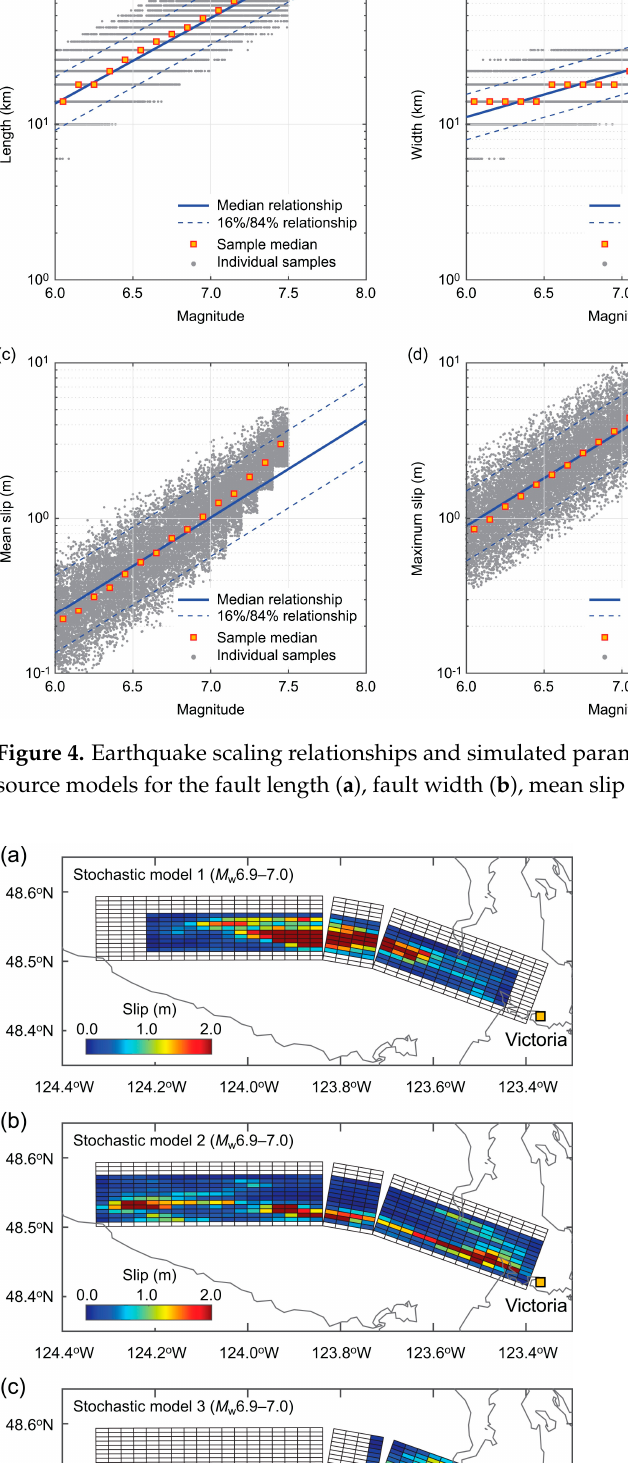
Figure 6. Average earthquake slip distributions of the 1000 stochastic source models: ( a ) M w 6.6–6.7 scenario, ( b ) M w 6.9–7.0 scenario, and ( c ) M w 7.2–7.3 scenario.